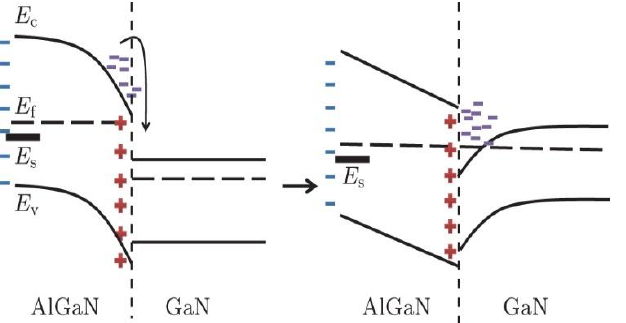
Figure 13. In the 2DEG quantum well, the buildup of electrons is shown in the energy band of an undoped AlGaN/GaN heterojunction. Reproduced with permission from Chin. Phys. B. [31].